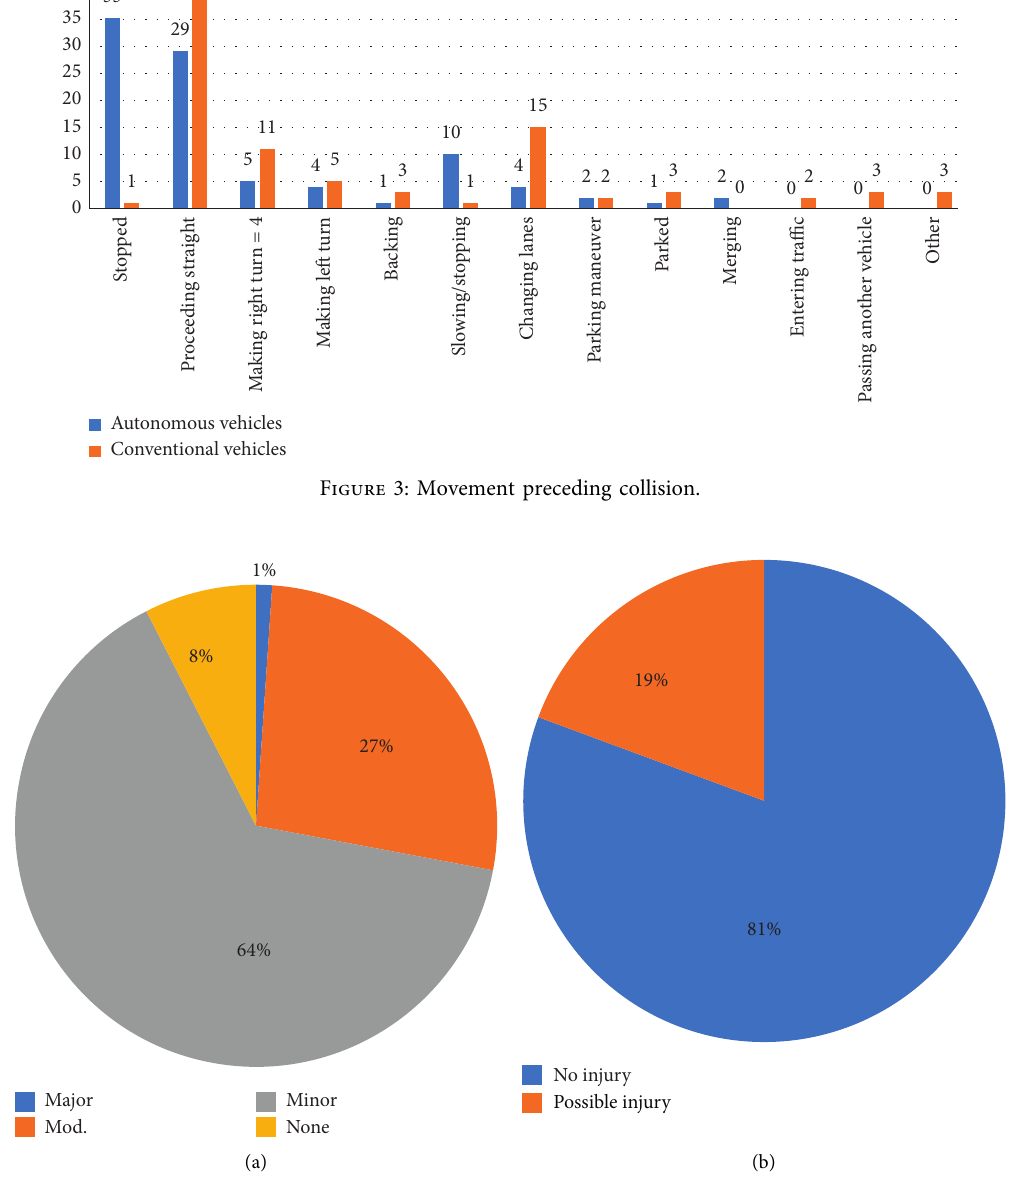
Figure 4: Crash severity and vehicle damage. (a) Vehicle damage description. (b) Crash